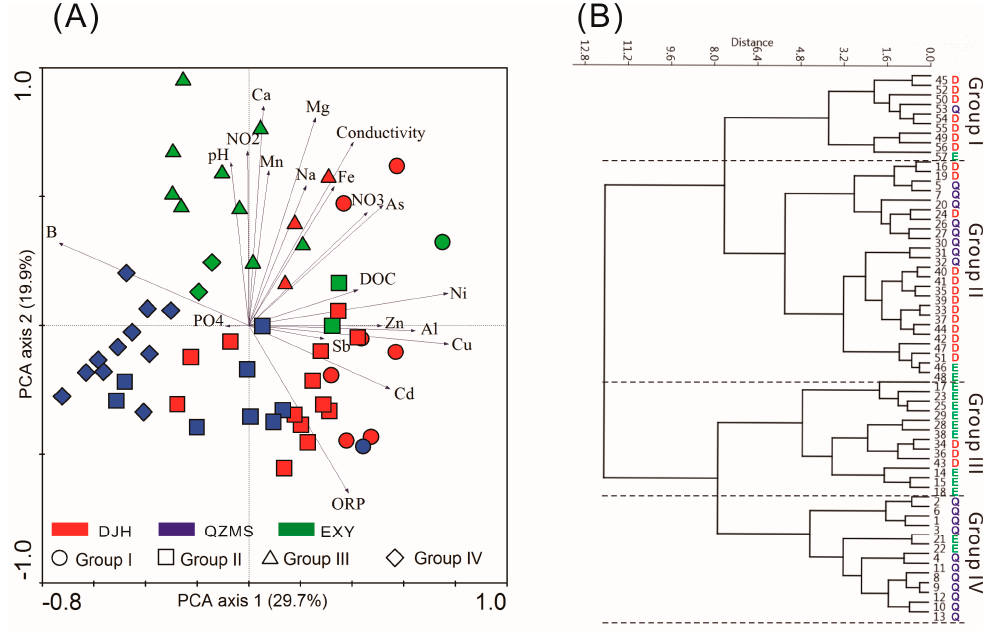
Figure 3. ( A ) Principal component analysis (PCA) ordination diagram of samples based on environmental parameters; ( B ) cluster analysis of samples using the method of Ward’s minimum variance. The color code represents samples from DJH (D), QZMS (Q), and EXY (E), and the symbol code in ( A ) represents the four groups.